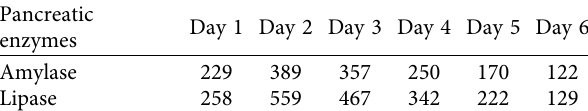
Figure 1: Pancreatic enzyme curve. Table 3: Pancreatic enzyme